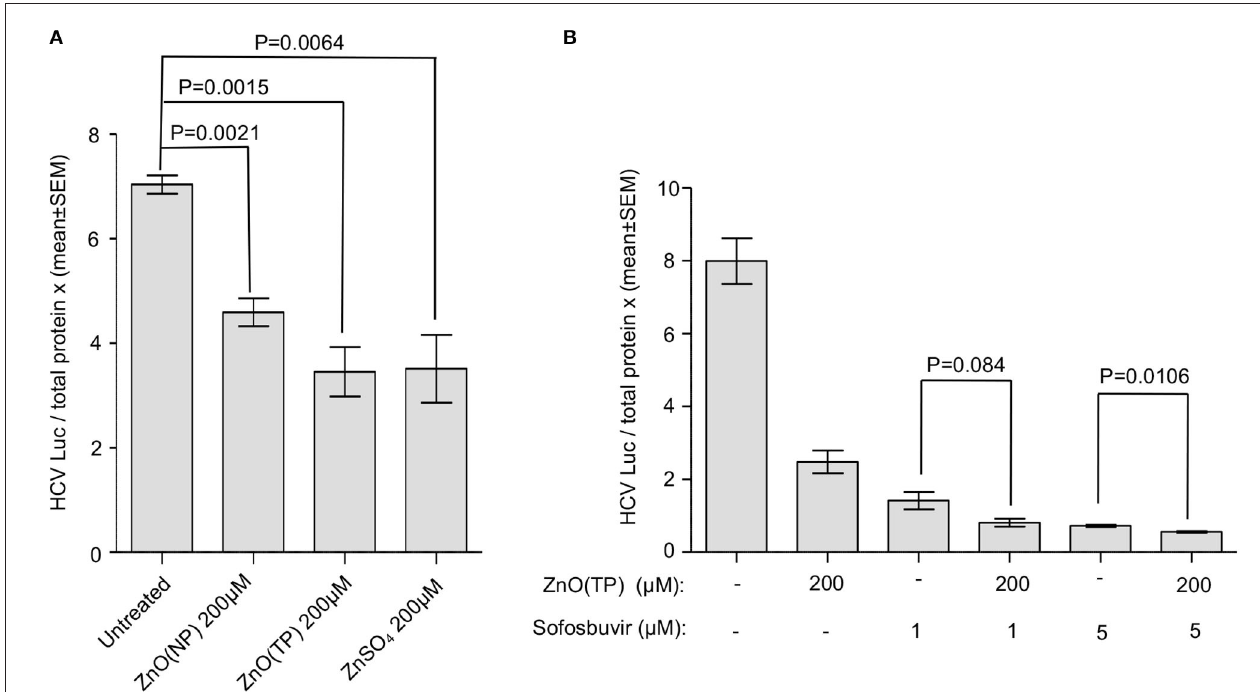
FIGURE 7 | Inhibition of HCV replication by zinc compounds. (A) G418-resistant g3a-HCV replicon expressing Huh7.5 cells were treated with indicated doses of ZnO(NP), ZnO(TP), and ZnSO 4 compounds for 24h. Firefly luciferase activity and total protein concentration were measured. Luciferase/total protein ratio is represented in the graph as mean ± SEM of three independent experiments. (B) G418-resistant g3a-HCV replicon expressing Huh7.5 cells were treated with 1 and 5 µ M sofosbuvir alone or cotreated with 200 µ M ZnO(NP) and ZnO(TP), respectively, for 24h. Luciferase/total protein ratio is represented in the graph as mean ± SEM of three independent